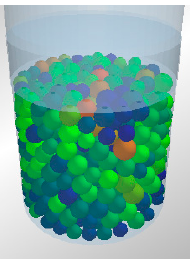
Figure 2. EDEM confining pressure simulation condition.